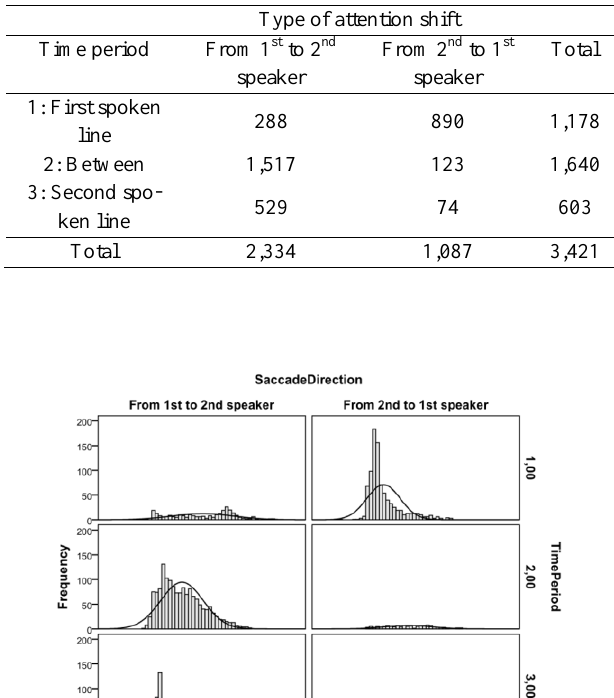
Frequencies of attention shifts during each time period.